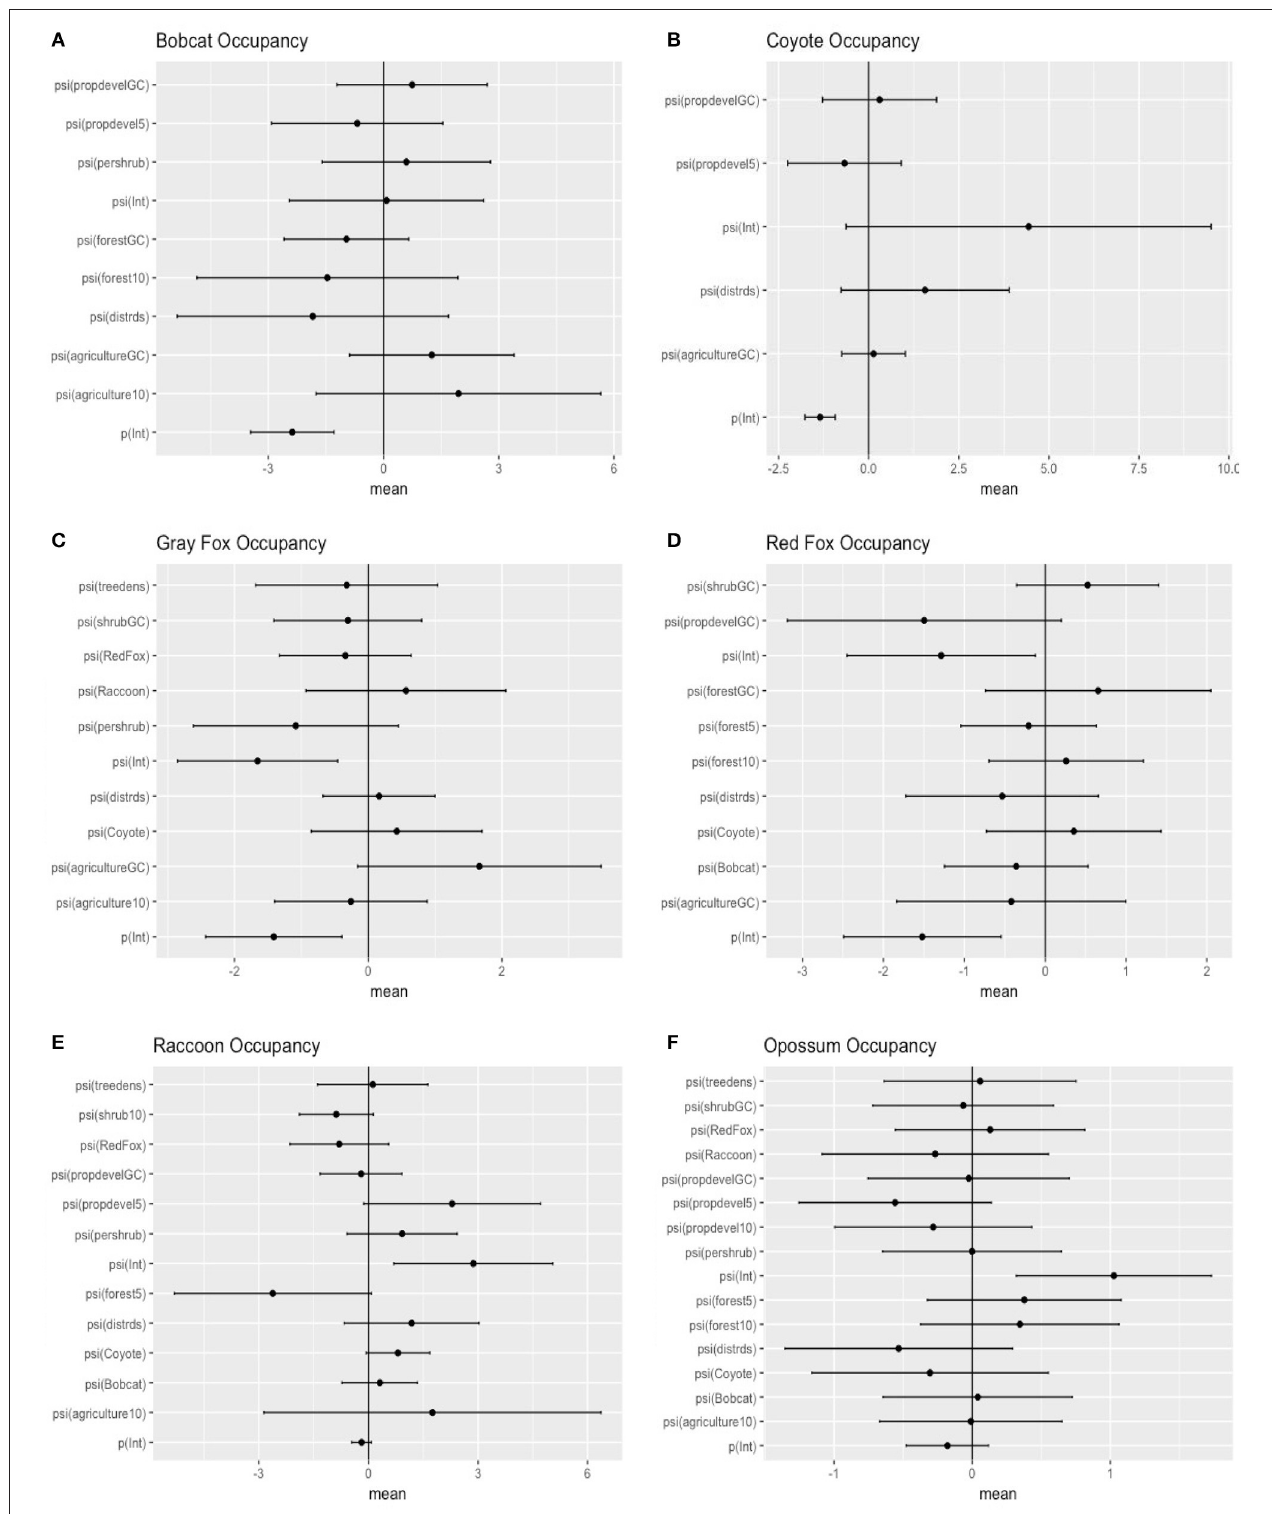
FIGURE 2 | Model-averaged standardized predictors for occupancy of six carnivore species in southeastern Ohio. Distrds, distance of camera from roads; Treedens, the number of trees within a 10m buffer around the camera; Pershrub, proportion shrub within 10m radius of camera; ShrubGC, proportion shrub within a grid